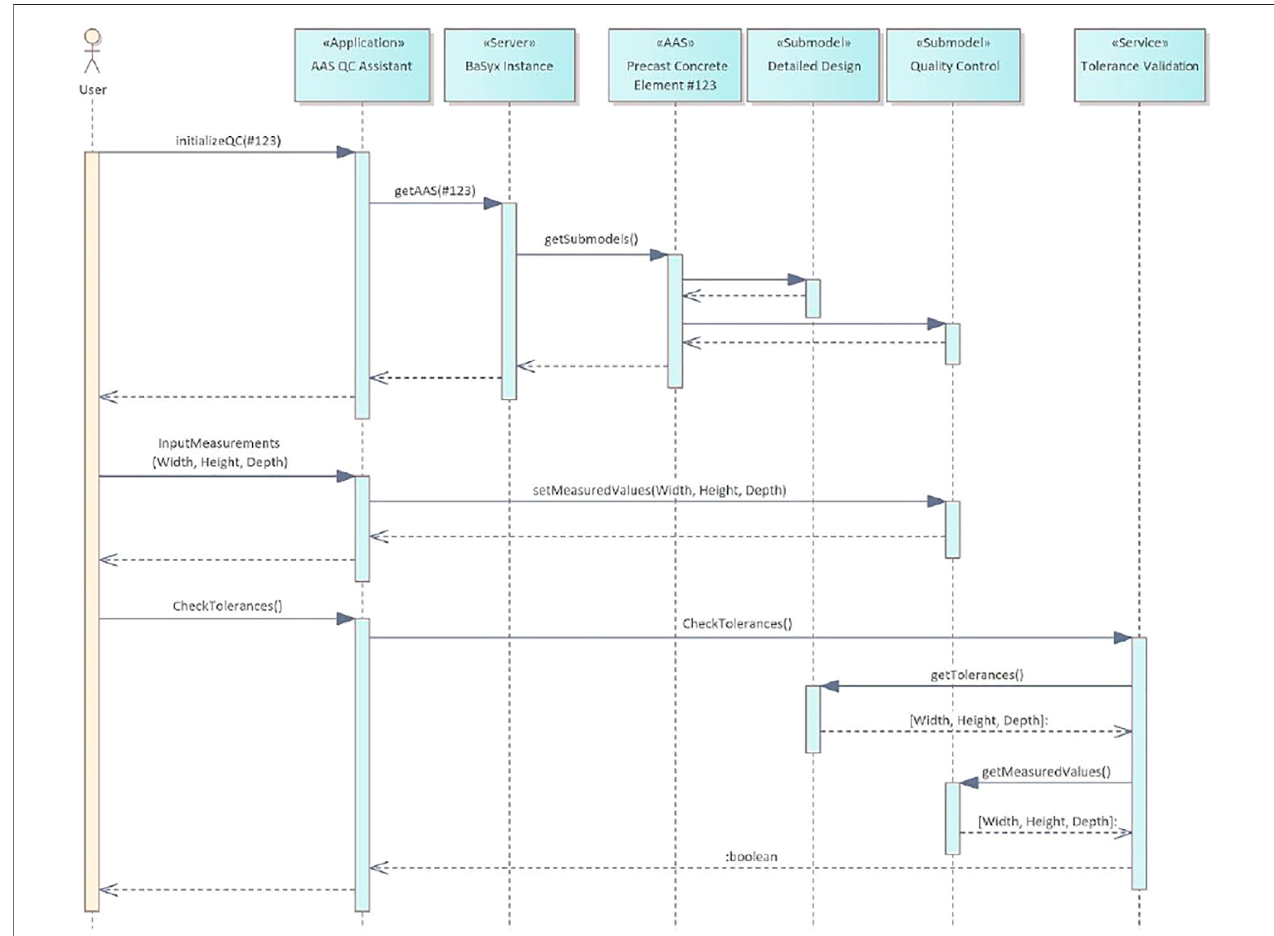
FIGURE 13 | Sequence diagram of the communication process in the